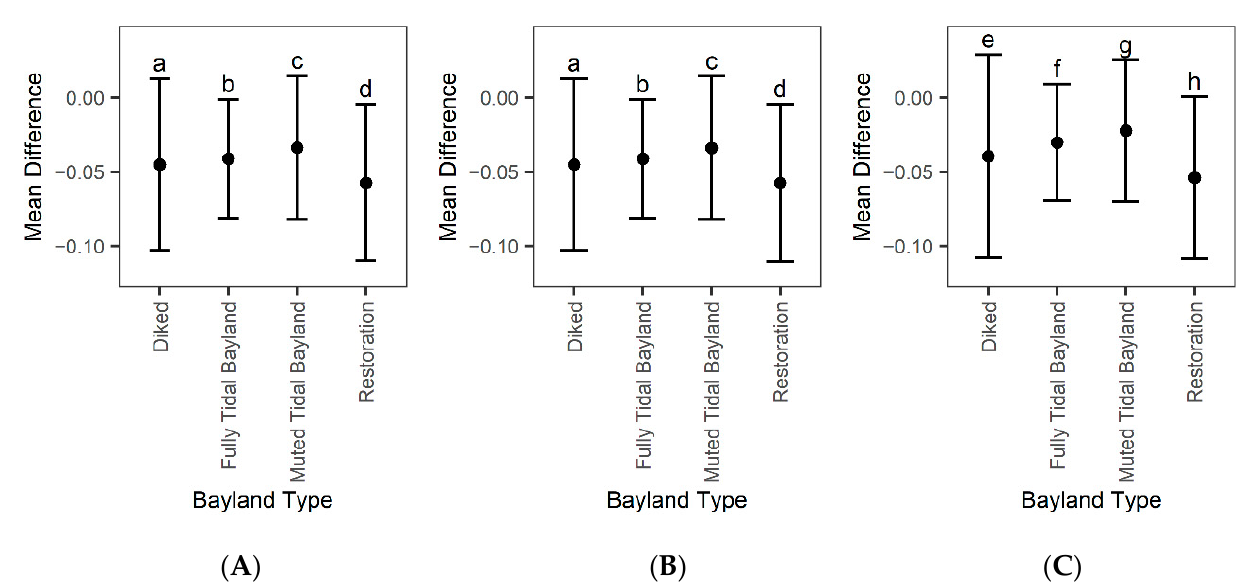
Figure A4. Mean difference (model error) plus or minus standard deviation based on bayland type. ( A ) Error based on modeling only using Landsat 8 for EVI history, ( B ) modeling including Landsat 8 and Sentinel for EVI history, and ( C ) Landsat 7 Landsat 8 and Sentinel for EVI history. Mean difference refers to predicted values minus 2019 Landsat observed data. Bayland type is defined by the San Francisco Estuary Institute’s Modern Bayland dataset. We compared the mean difference across the three panels; bayland type errors with a different letter code are significantly different from each other based on Tukey’s HSD.